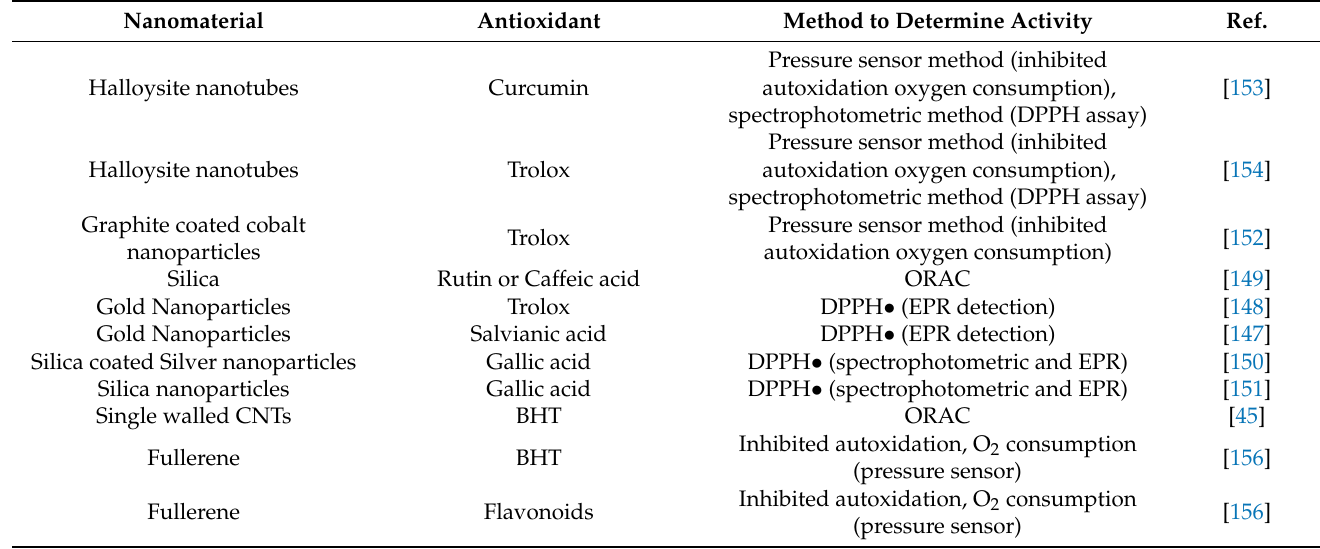
Table 3. Antioxidant nanoparticle efficacy testing methods and